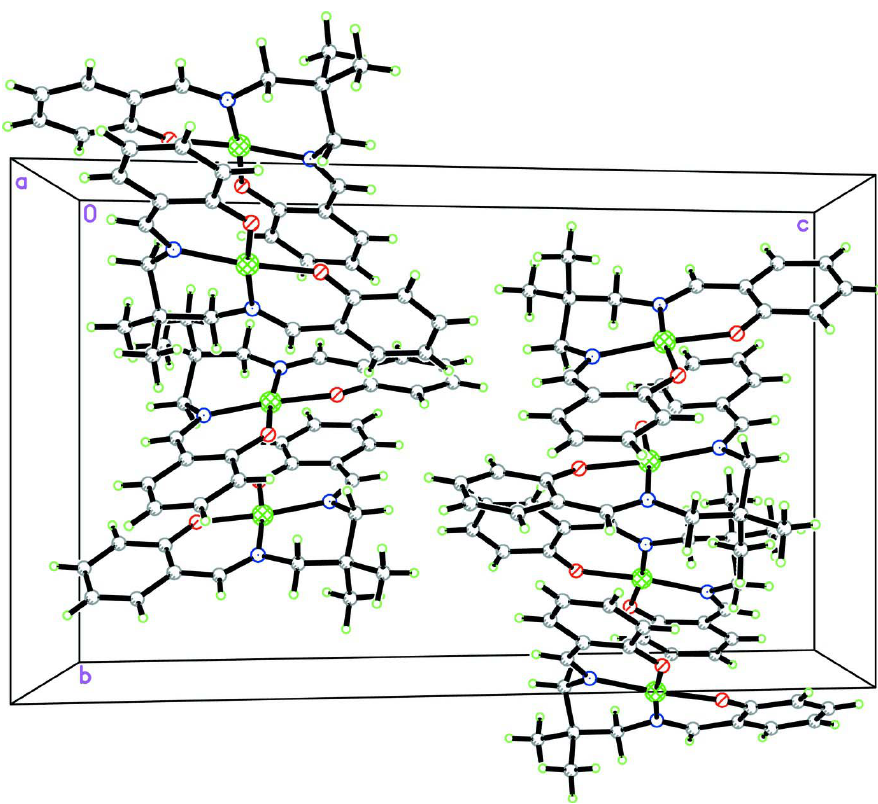
Figure 2 Crystal packing of (I), viewed along the a axis showing the stacking of the molecules along the b direction. The disordered ethanol molecule is omitted for